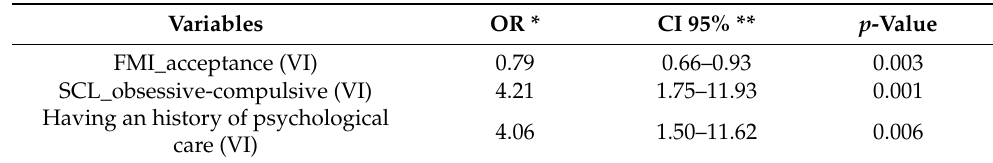
Table 6. The final model resulting from the multivariate b selection procedure. In this procedure only variables were included that were significant in the univariate regression